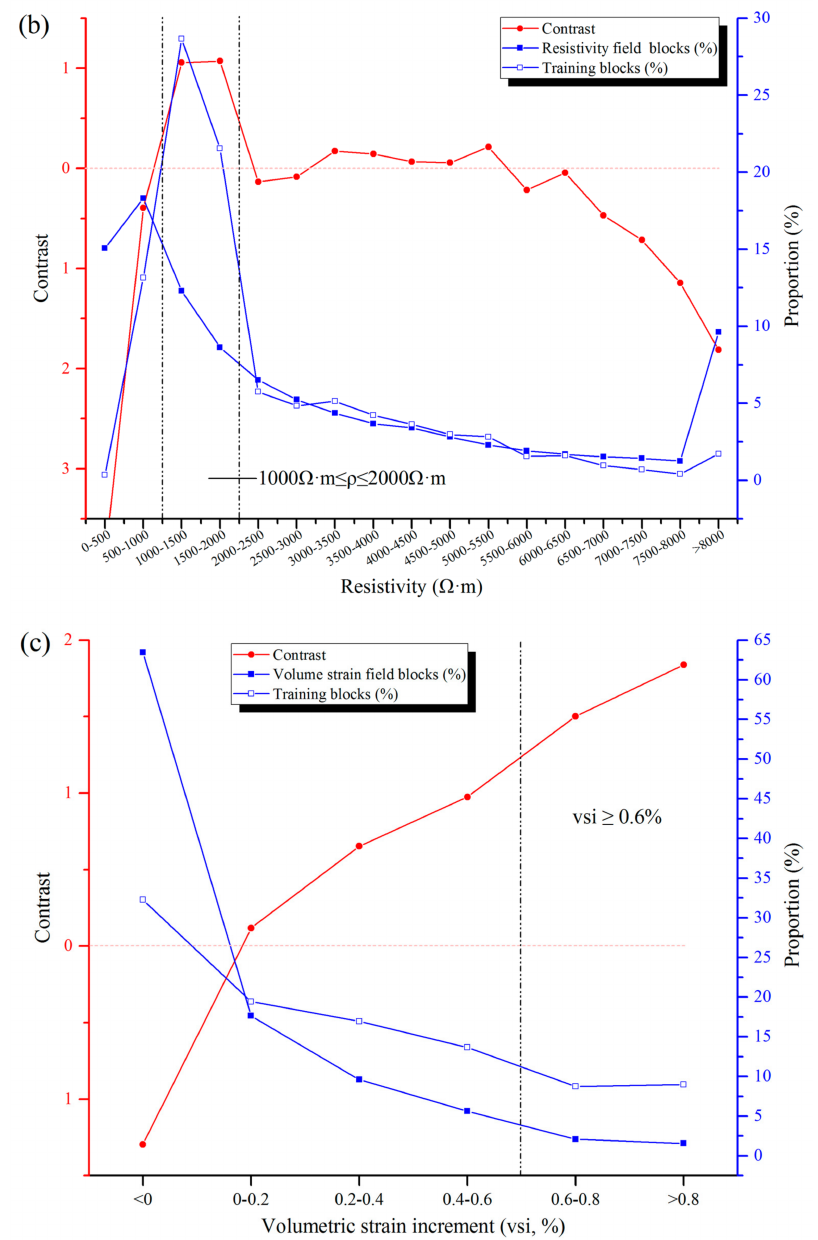
Figure 6. Contrast curves against the proportion of training blocks and evidential factors blocks at different intervals, ( a ) for buffer around chosen abnormal zones; ( b ) for resistivity field; ( c ) for volume strain